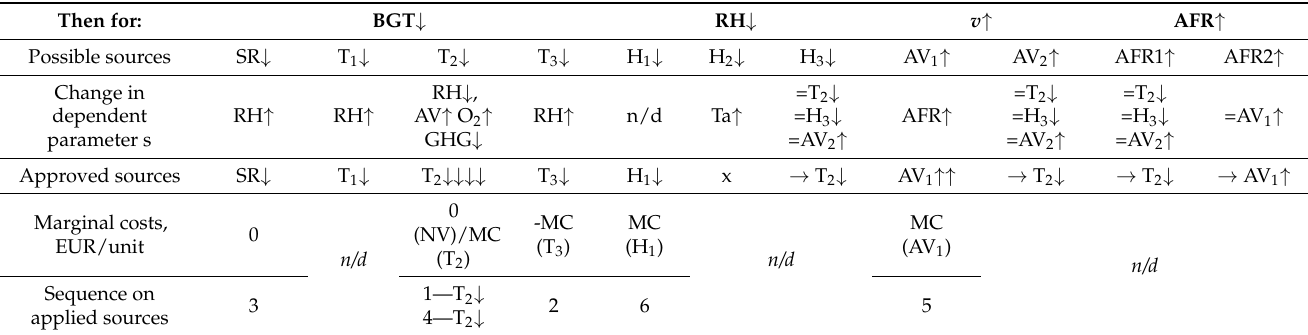
Table 10. Algorithm in a sequence for applying sources to regulate the